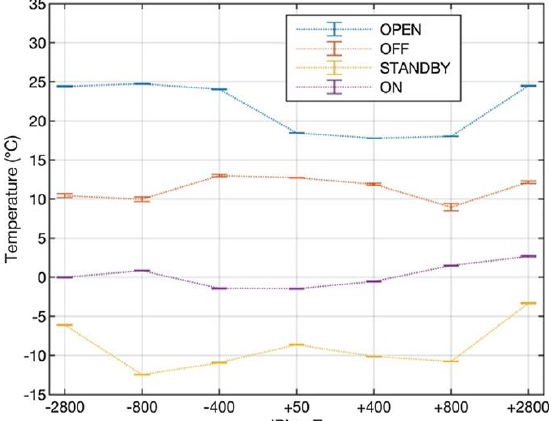
Figure 29. Longitudinal layout of the fiber optic monitoring system installed on the CMS central BP. The quotes indicate the positions, relative to the center of the central BP of the FBG sensors. All the Figure 29. Thermal profile of the beam pipe relative to different operational status of the CMS de- tector, occurring in 2018 (adapted from Ref. [130]). quotes refer to the FBG sensors of a single fiber, with respect to the center of the central BP. Four fibers have been installed in the cardinal position of the BP (adapted from Ref.